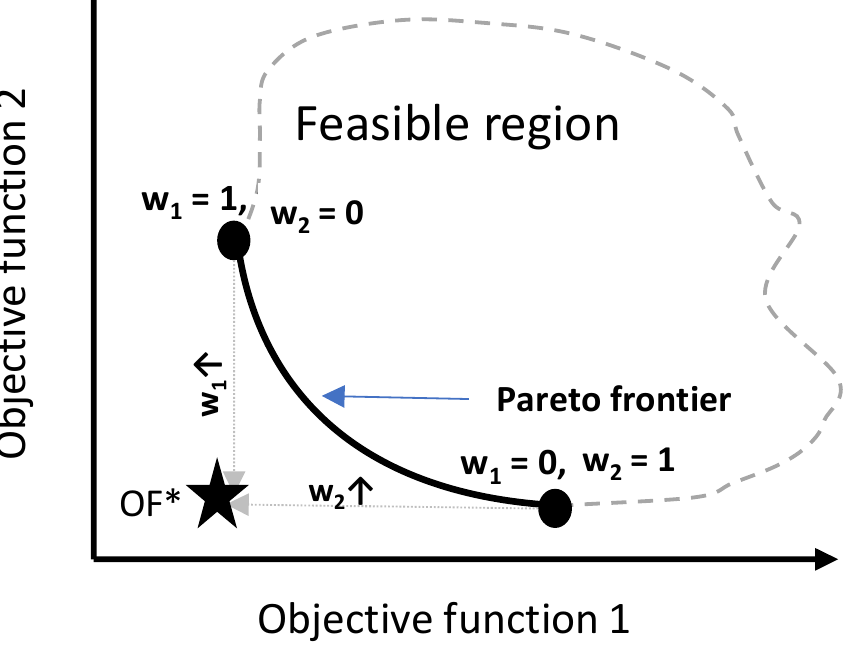
Figure 2. Illustration of Pareto frontier. The utopia point ( OF ∗ ) corresponds to the optimum of both objective functions 1 and 2. However, there is typically no feasible solution at utopia point as demonstrated in the